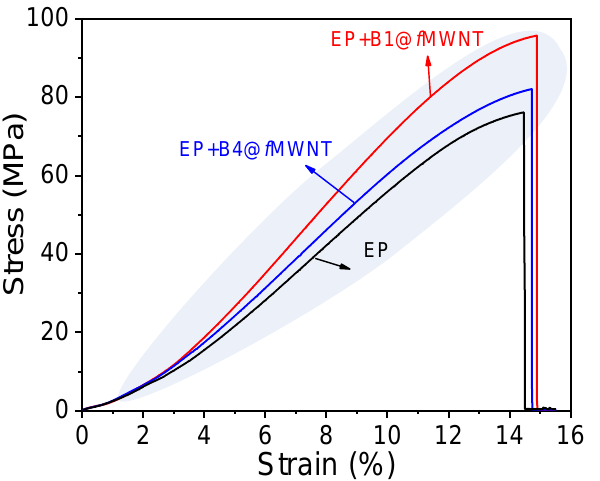
Figure 7. Stress–strain curves of epoxy, epoxy composites with 0.05 wt% B1@ f MWNTs and Figure 7. Stress – strain curves of epoxy, epoxy composites with 0.05 wt% B1@ f MWNTs and B4@ f MWNTs.